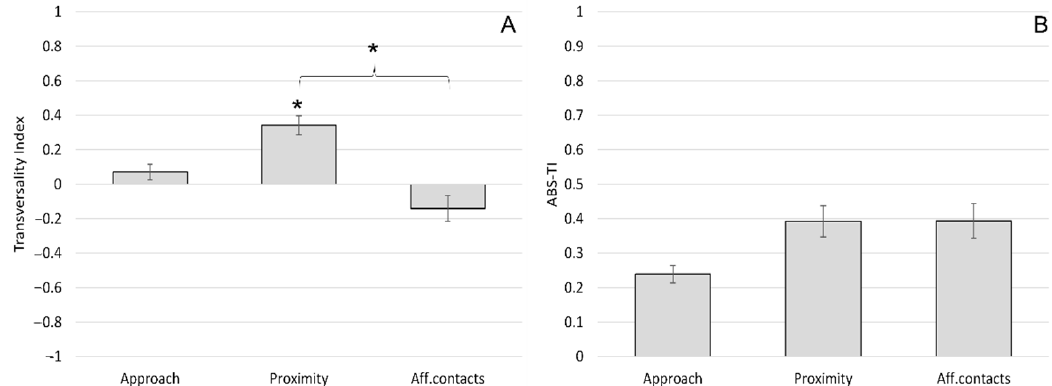
Figure 3. Sagittal preference during social interactions in Barbary macaques . Mean Transversality Index (TI) ( A ) and mean ABS-TI ( B ) of different social interactions (approach, proximity and affiliative contact). Bars indicate standard error. Asterisks (*) indicate significant group-level biases and significant differences between social interactions (Tukey post hoc test: p < 0.05).